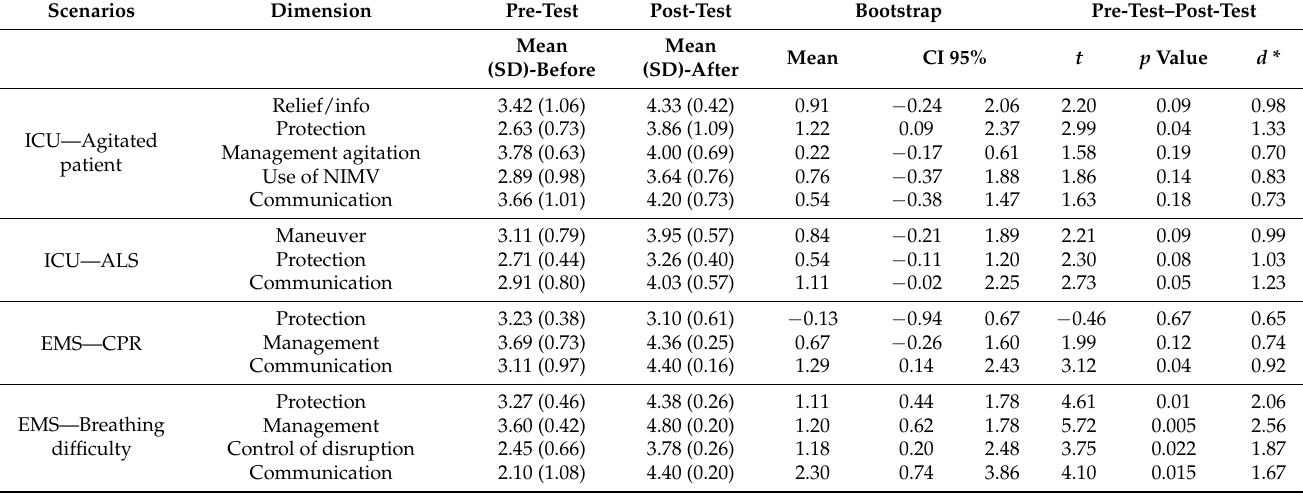
Table 6. Results of the intervention evaluations for each of the scenarios (initial and repeated). Scenarios